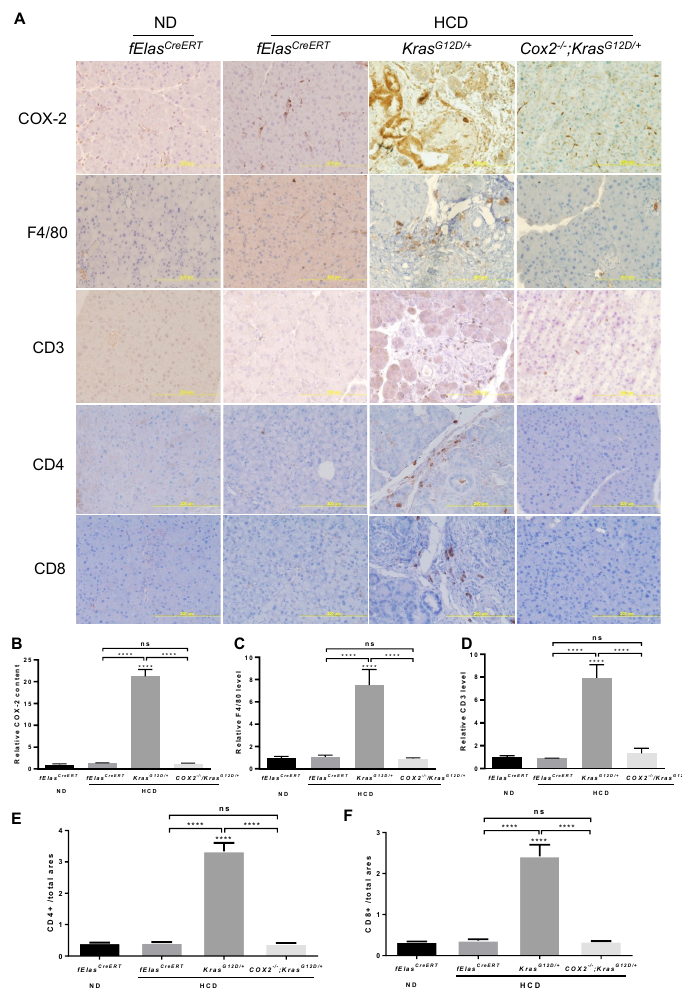
Figure 5. Effects of COX-2 deficiency on the HCD and KRAS G12D/+ mediated pancreatic inflammation and immune cell infiltration. ( A ). Immunohistochemical analyses of mouse pancreata from the indicated four groups with antibodies against COX-2, F4/80, CD3, CD4, and CD8. Magnification: 200 × . ( B – F ). Quantification of IHC stains of COX-2, F4/80, and CD3, CD4, and CD8, respectively. NS, not significant. ****, p -value <